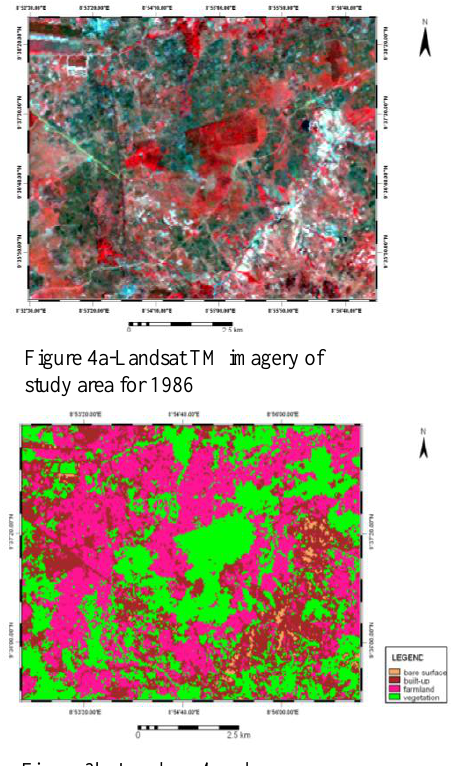
Figure 4a-Landsat TM imagery of study area for 1986